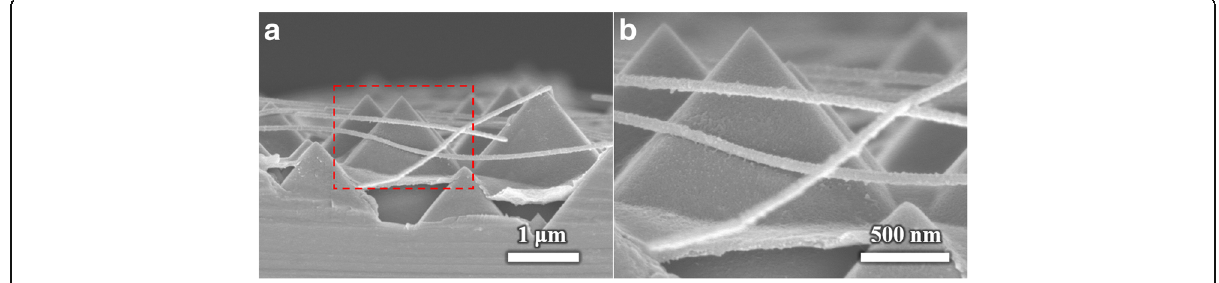
Fig. 9 a The cross-sectional view of PEDOT:PSS/n-Si solar cells with AgNWs electrodes. b The detailed image of red